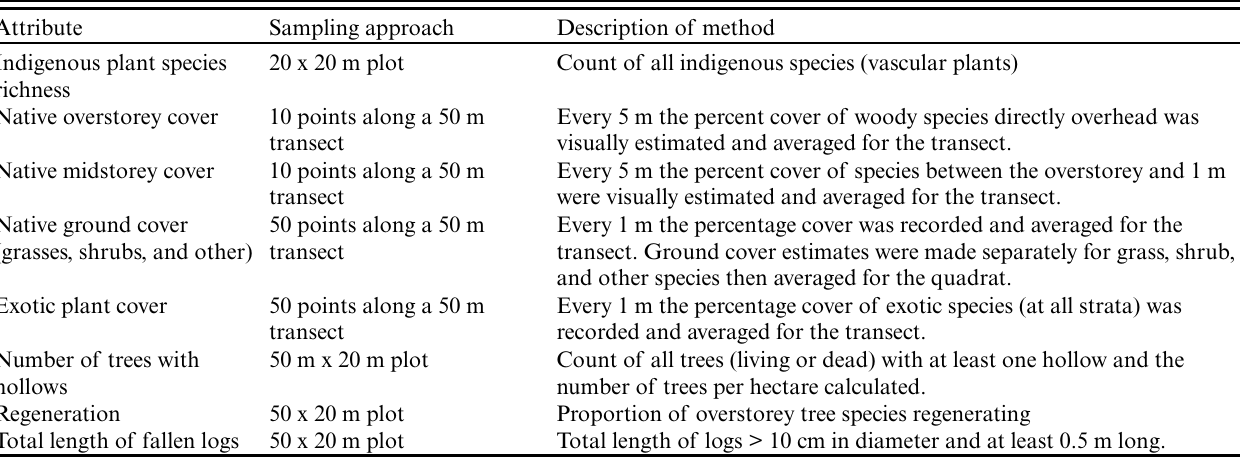
Table 2 . The condition attributes measured using the site value component of the BioMetric tool (Gibbons et al. 2005).